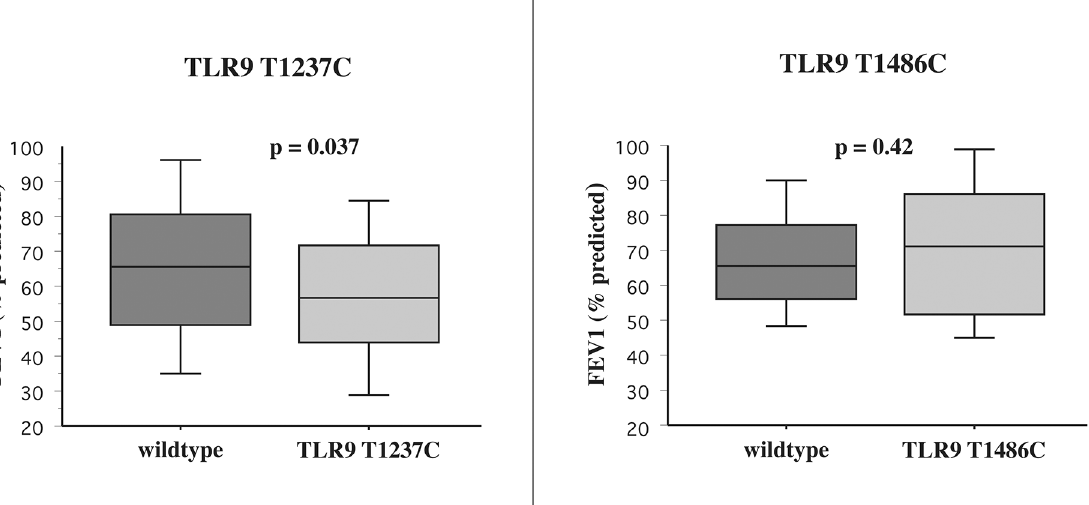
Fig 4. TLR9 SNPs and FEV 1 %predicted. Correlation of FEV 1 %predicted and expression of TLR9 wildtype (dark shading) compared with (T1237C) (light shading) is shown in left panel. Correlation of FEV 1 %predicted and expression of TLR9 wildtype (dark shading) compared with TLR9 (T1486C) (striped shading) is shown in right panel. Results are given for all COPD